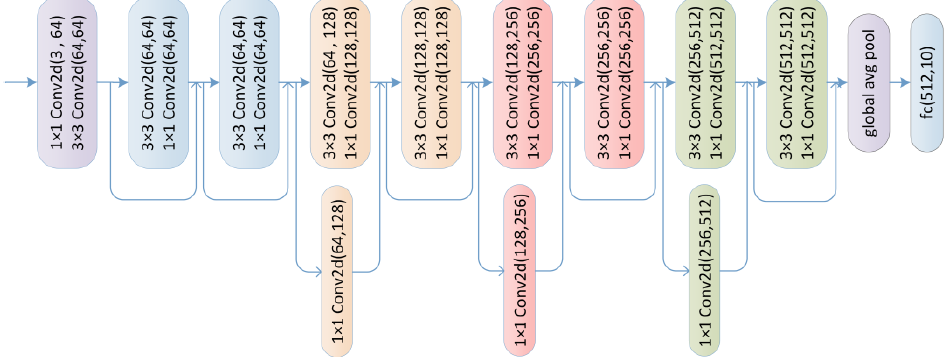
Figure 4. Architecture of SAR-BagNet.